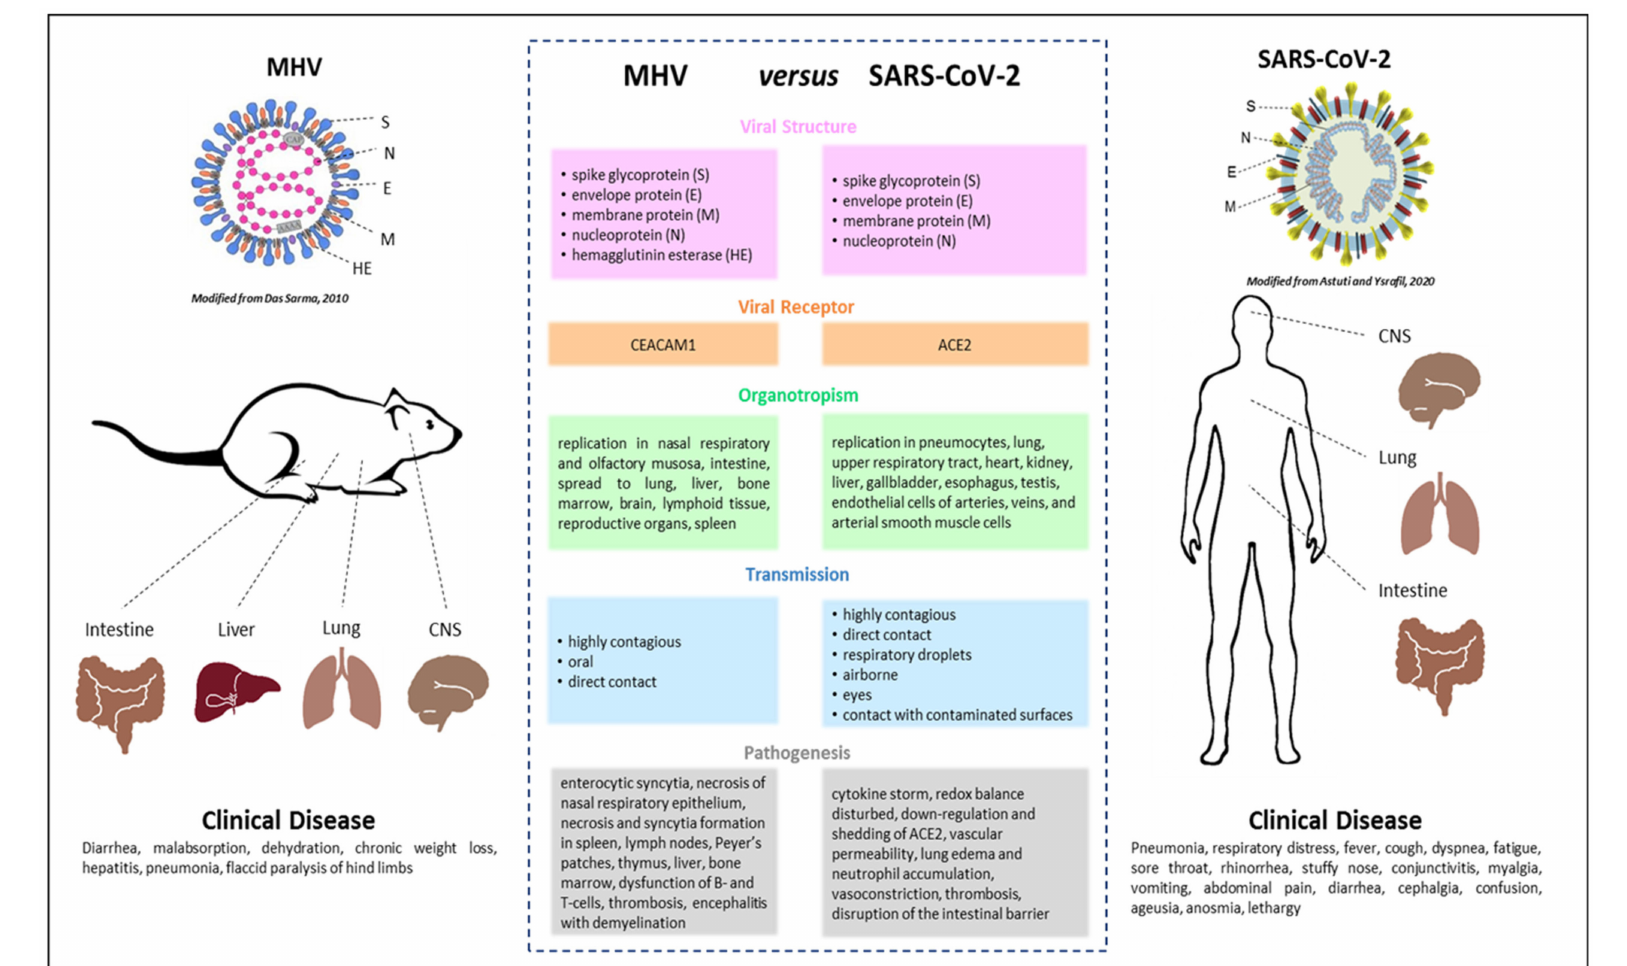
Figure 1. Summary of the main similarities and di ff erences between the coronaviruses mouse hepatitis virus (MHV) and severe acute respiratory syndrome coronaviruses 2 (SARS-CoV-2). The images for MHV [155] and SARS-CoV-2 [156] in this figure were